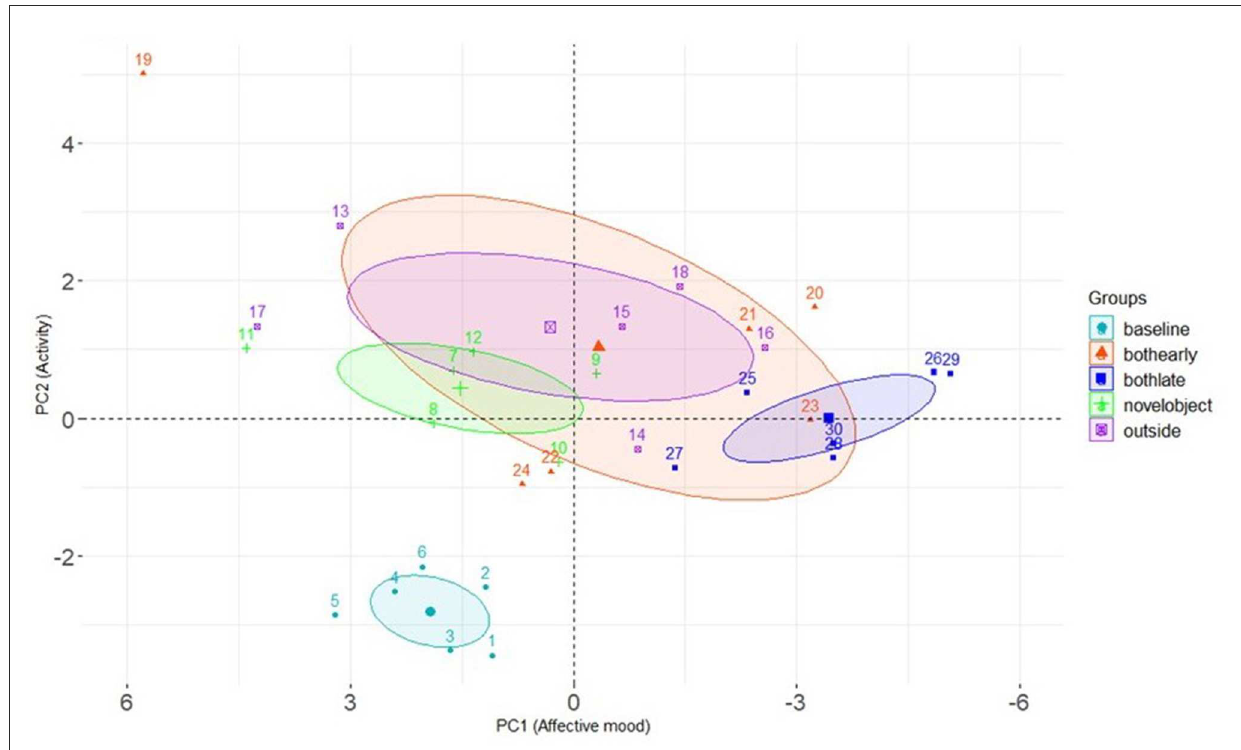
FIGURE7 Group 2: Biplot displaying all QBA assessment scores in terms of PC1 and PC2. Each separate point displays one assessment date. Points are coded per treatment period [baseline, novel object, outside, both resources (early) and both (late)] as indicated on the plot. Group means are in bold and ellipses indicate the 95% confidence intervals of the group